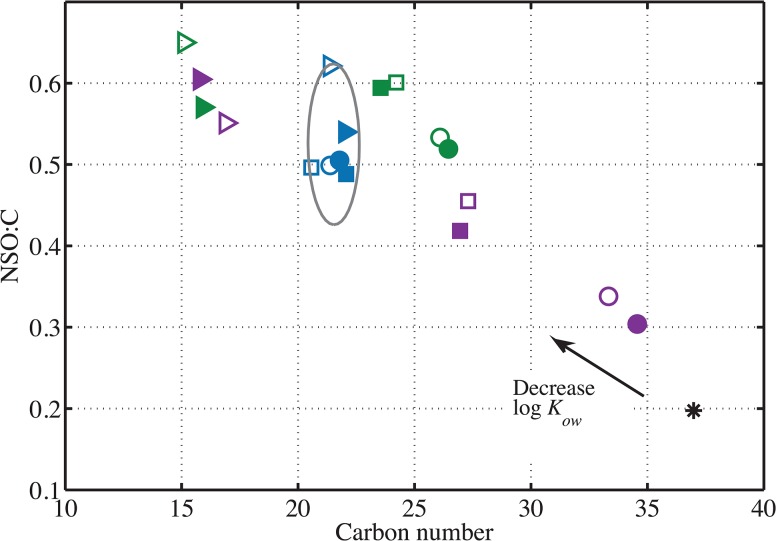
Number-averaged carbon number (C#) vs. NSO:C for each sample and control.Filled symbols indicate data collected from the VSW treatment and open symbols indicate data collected from the VSWE treatment. Circles, squares and triangles indicate DCM 1, DCM 2, and DCM-PPL extracts, respectively. Each extract of the seawater control is plotted in blue. The seawater controls are clustered together within a 95% confidence ellipse. Water-accommodated fractions (WAF) are plotted in purple symbols. Water-soluble fractions (WSF) are plotted in green symbols. The crude oil control is represented by a black asterisk.